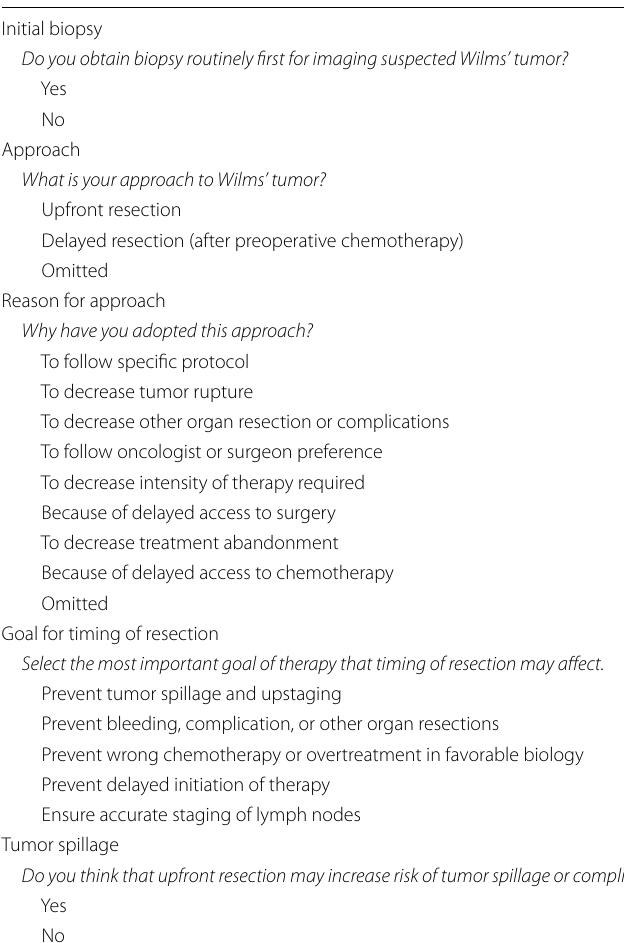
Table 1 Current approach to Wilms’ tumor management in LMICs Initial biopsy